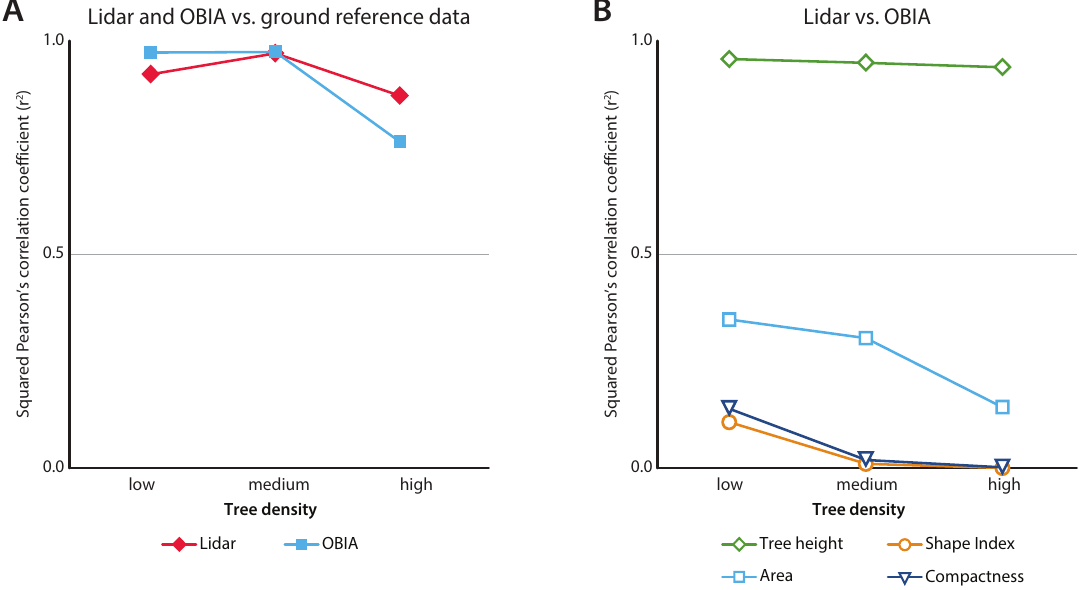
Figure 10. The tree height agreement between ground reference data and derived polygons decreased in high tree density areas ( A ). The area, shape complexity, and predicted tree heights of the derived polygons were more different in the high tree-density areas ( B ). Tree height and polygon shape: effects of tree